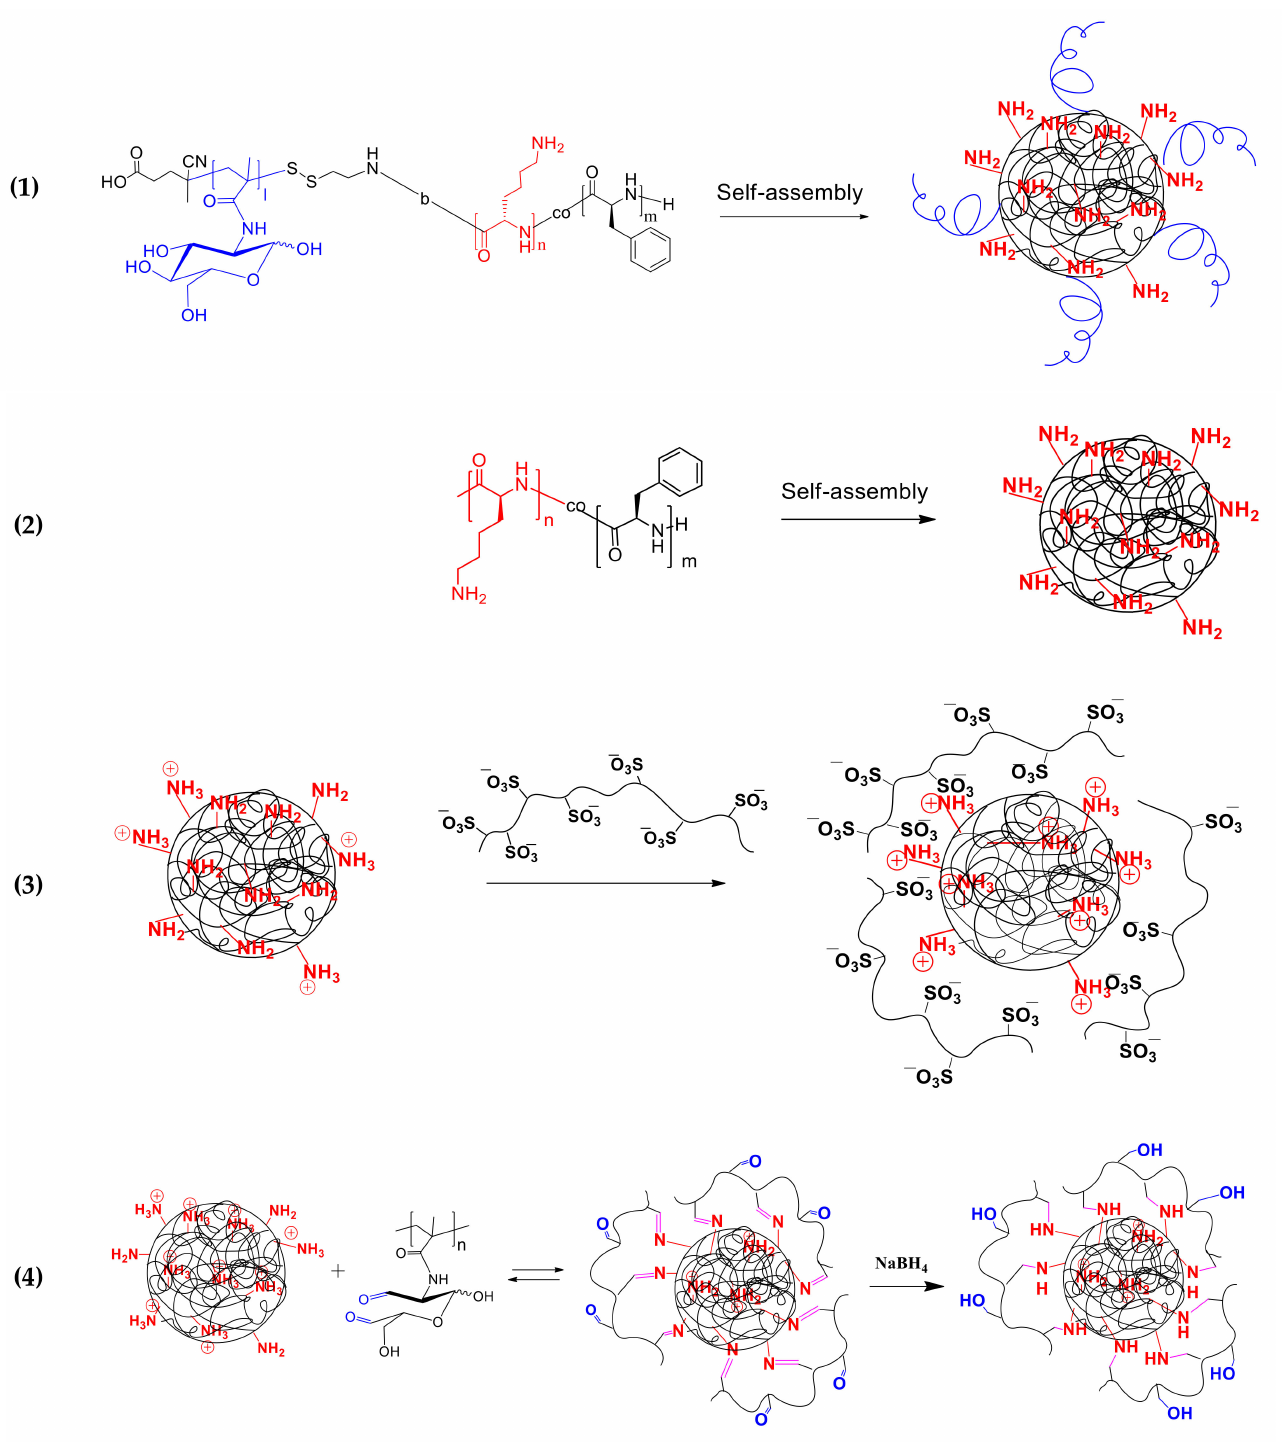
Figure 4. Schematic representation of: ( 1 ) PMAG- b -P(Lys- co -Phe) self-assembly; ( 2 ) P(Lys- co -Phe) self-assembly; ( 3 ) covering of P(Lys- co - D -Phe)-based NPs with heparin; ( 4 ) covalent modification of P(Lys- co - DL -Phe)-based NPs with